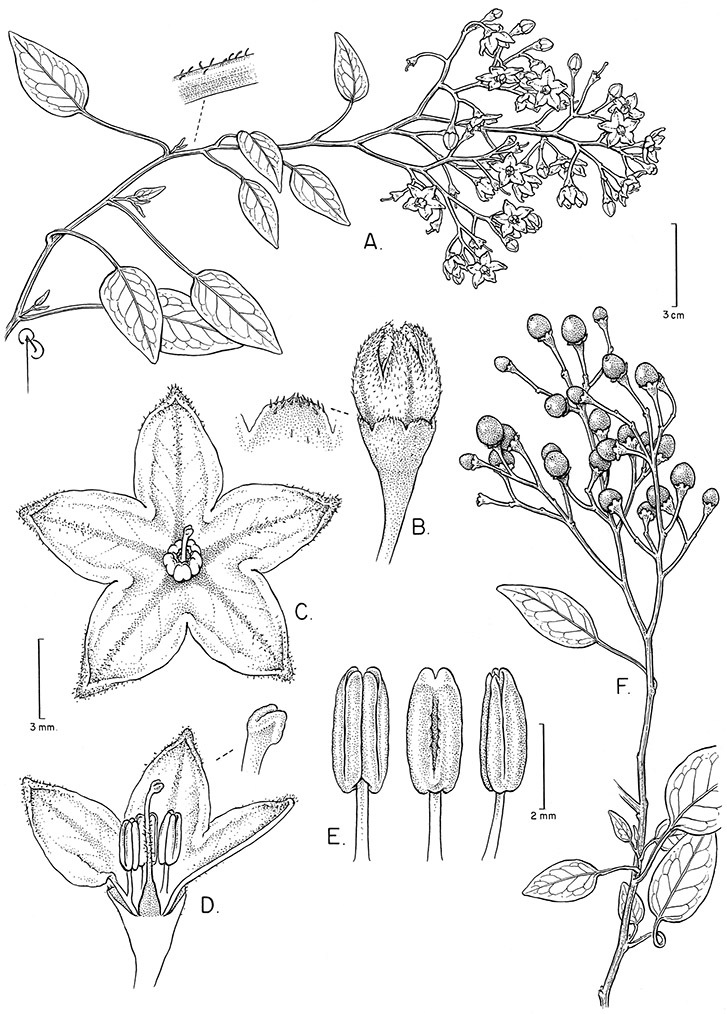
Solanum pyrifolium Lam. (A–E drawn from Colella 1361 and M. Nee unvouchered photographs from Hispaniola F drawn from Gastony et al. 525). Illustration by Bobbi Angell.